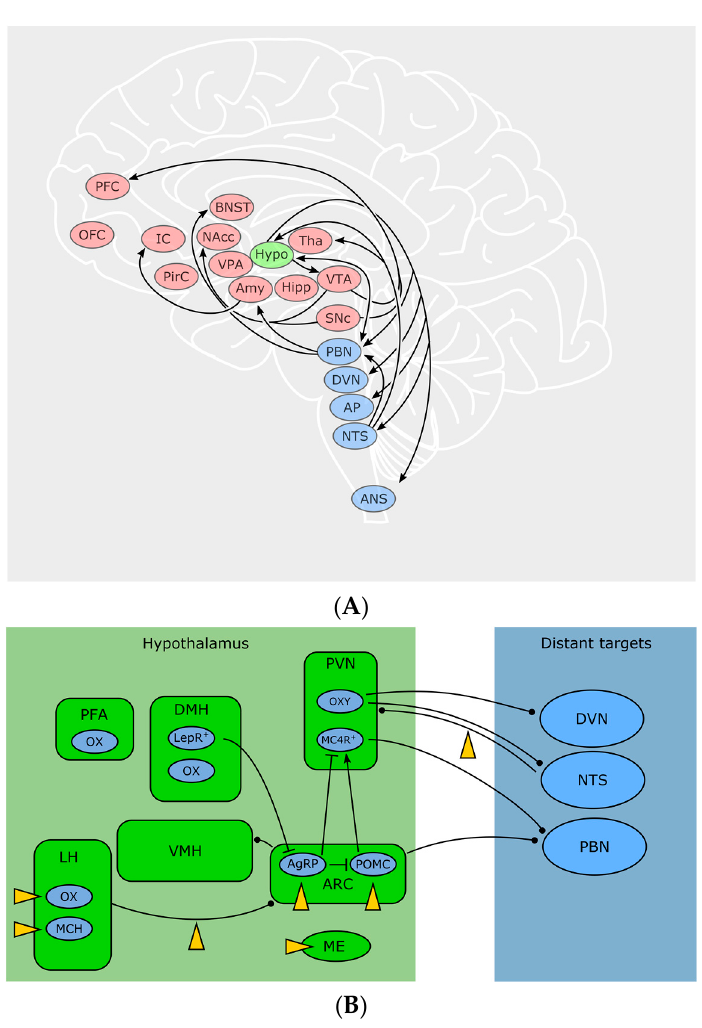
Figure 2. ( A ) Brain regions where the ECS influences different aspects of